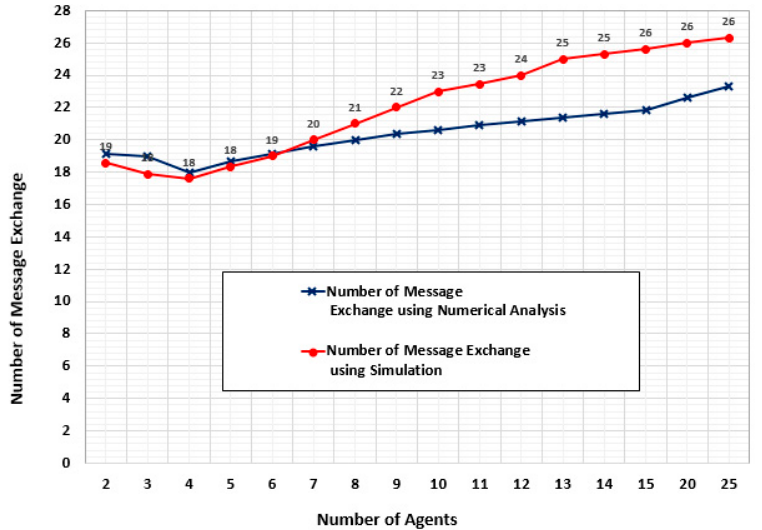
Figure 16. Comparison between the number of messages exchanged in the numerical analysis and simulation.